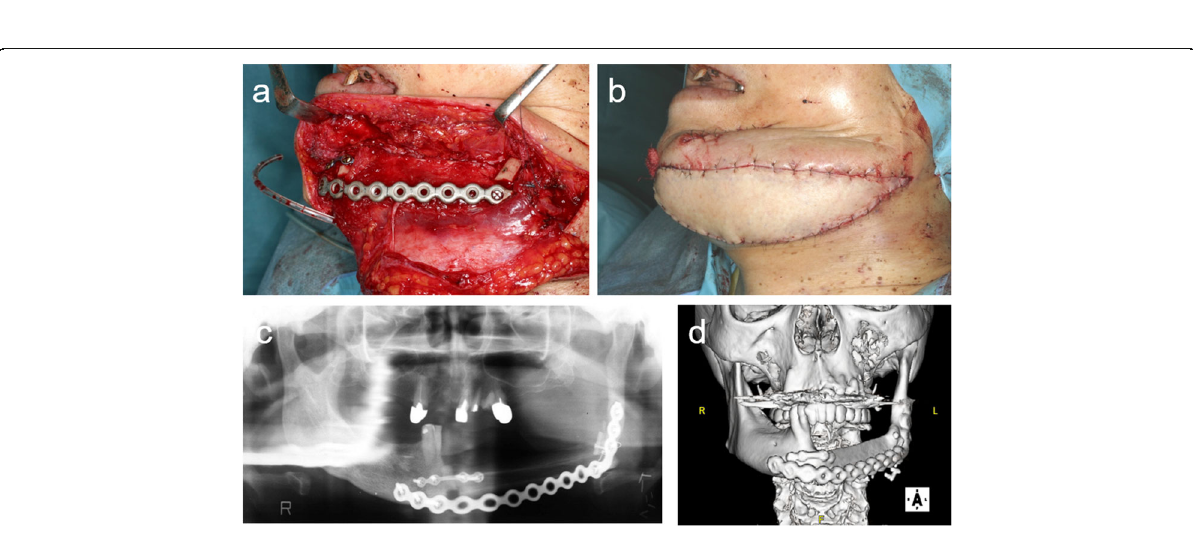
Fig. 8 a , b The mandible was reconstructed secondarily with a free vascularized fibula flap 1 year and 7 months after segmental mandibular resection. c Orthopantomogram and d 3-D computed tomography scan after mandibular reconstruction with a free vascularized fibula flap